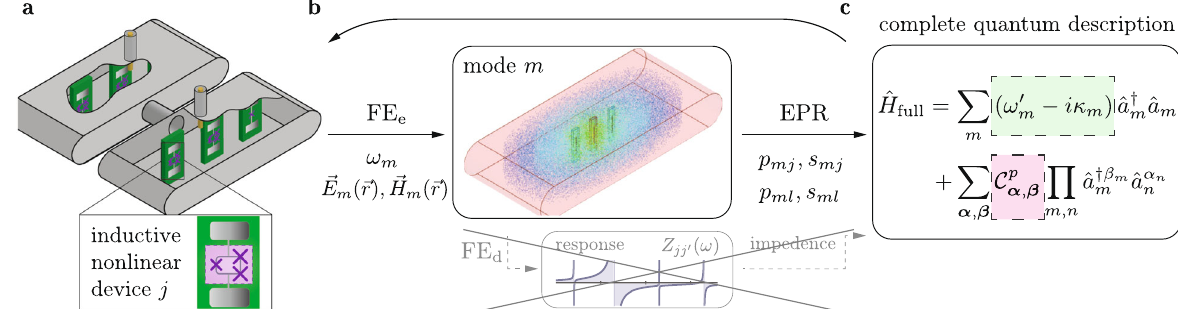
(cid:8) (cid:8) (cid:8) (cid:8) ! (cid:8) pro fi le (red: high; blue: (cid:8) m